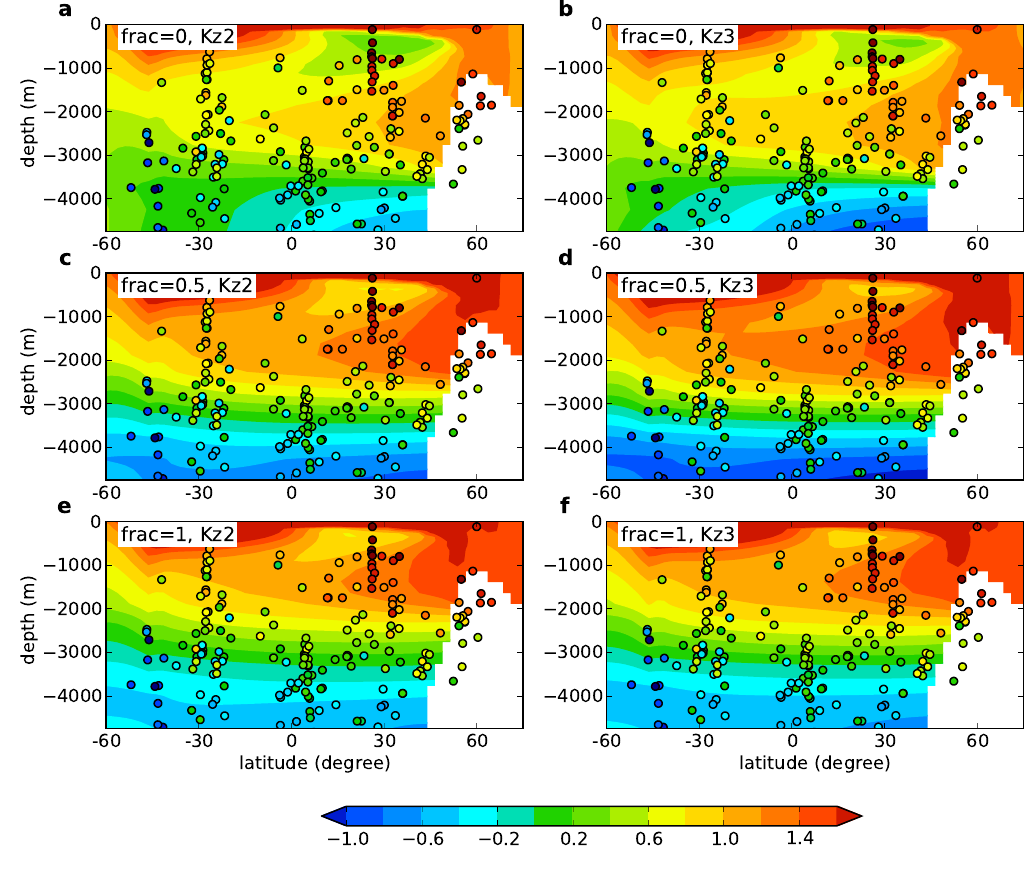
Fig. 10. δ 13 C (‰) distribution in the Atlantic. The dots represent the LGM data (Curry and Oppo, 2005; K¨ohler and Bintanja, 2008). (a) , (b) , (c) , (d) , (e) , (f) Modelled δ 13 C distribution: (a), (c), (e) with the low diffusion profile Kz2 (Fig. 7); (b), (d), (f) with the low diffusion profile Kz3 (Fig. 7). (a), (b) frac =0 (no impact of brines), (c), (d) frac =0.5 (medium impact of brines), (e), (f) frac =1 (maximum impact of brines).